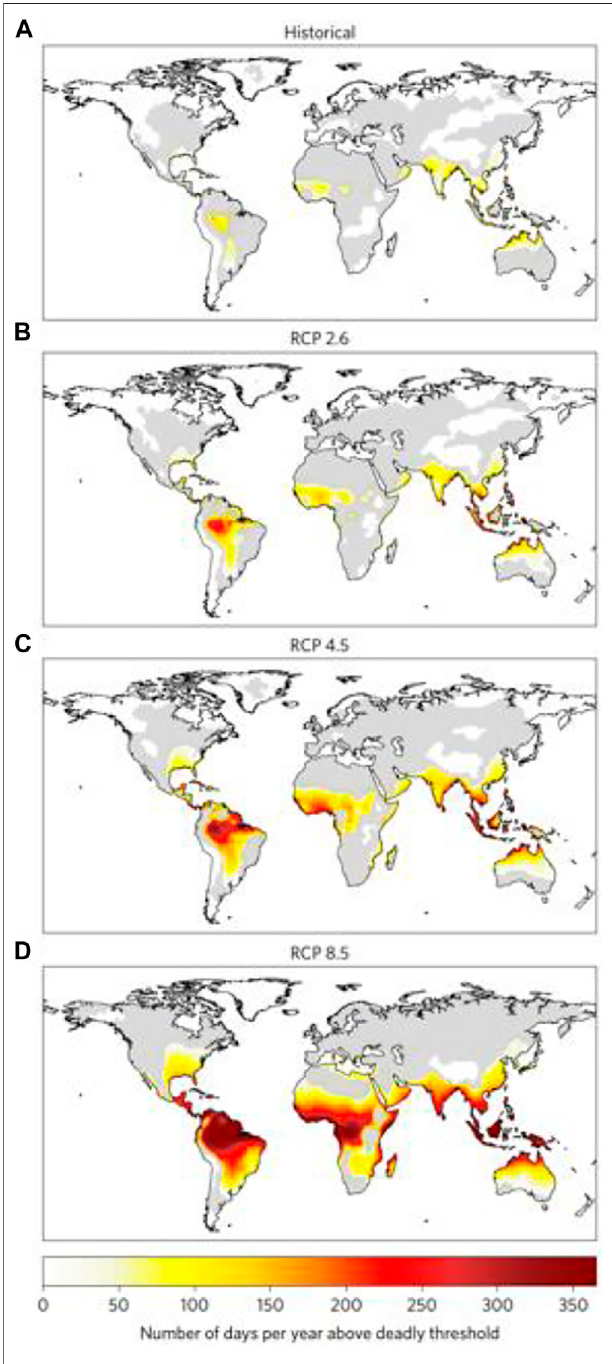
FIGURE 5 | Global patters of the number of days per year above deadly threshold(totheleftoftheblueLinein Figure4B )for1995 – 2005averageand for different emission scenarios. From Mora et al. (2017). Reprinted by permission.